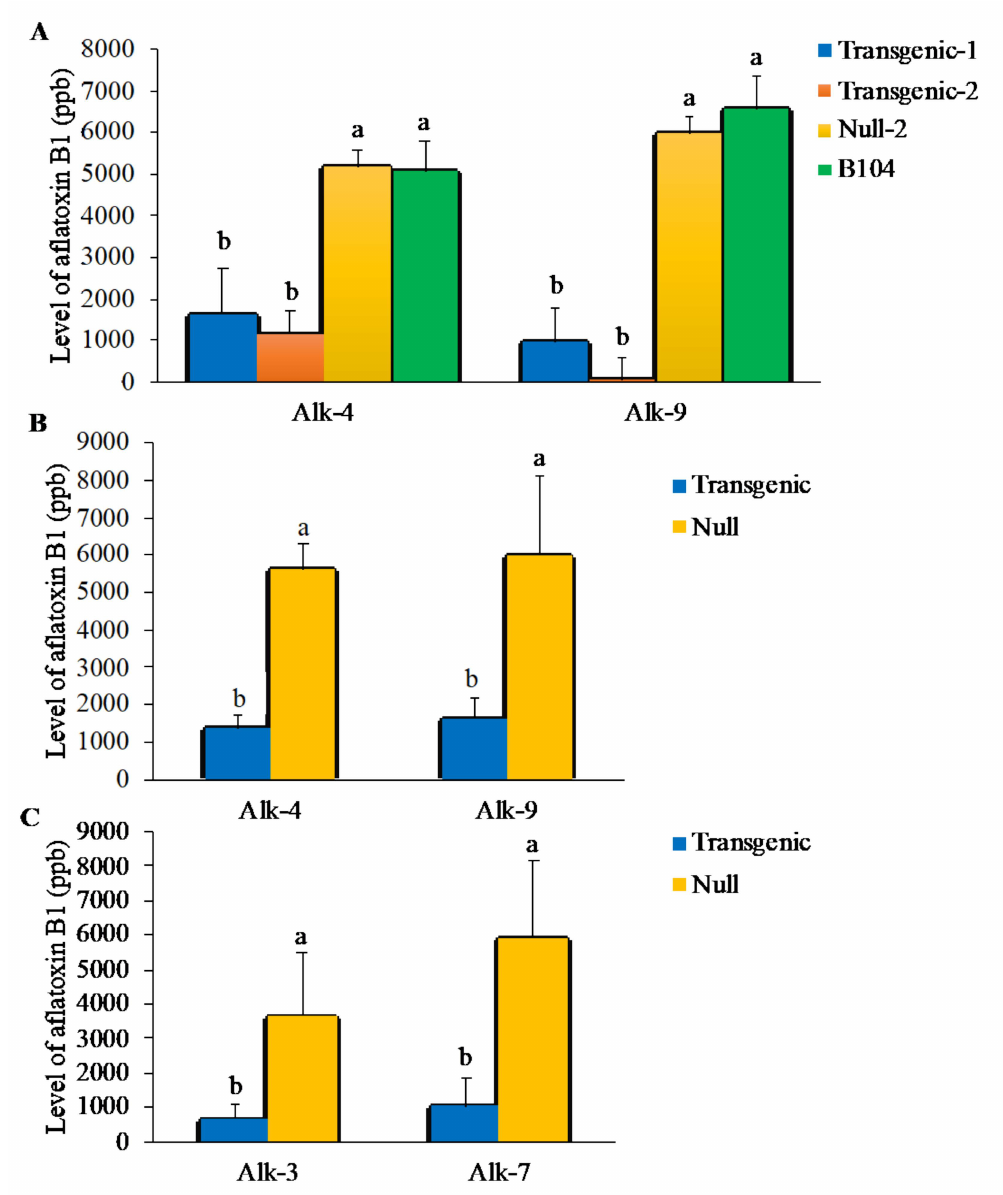
Figure 3. Evaluation of homozygous Alk transgenic lines under field inoculation conditions. ( A ) Aflatoxin production in T5 generation mature kernels of transgenic Alk lines and their null controls under field inoculation conditions. ( B ) Aflatoxin production in the T6 generation mature kernels of transgenic Alk-4 and Alk-9 lines and their null controls under field inoculation conditions. ( C ) Aflatoxin production in the T4 generation mature kernels of transgenic Alk-3 and Alk-7 lines and their null controls under field inoculation conditions. The inoculum concentration of 1 × 10 5 conidia/mL was used for these experiments. Bars with different letters are significantly different at p ≤ 0.05. Analysis was carried out using 10–14 ears with 3–4 samples per ear for each of homozygous, null and B104 lines. Transgenic represents the kernels from ears that contain alk . Null refers to kernels from ears of the same transformation events without the alk